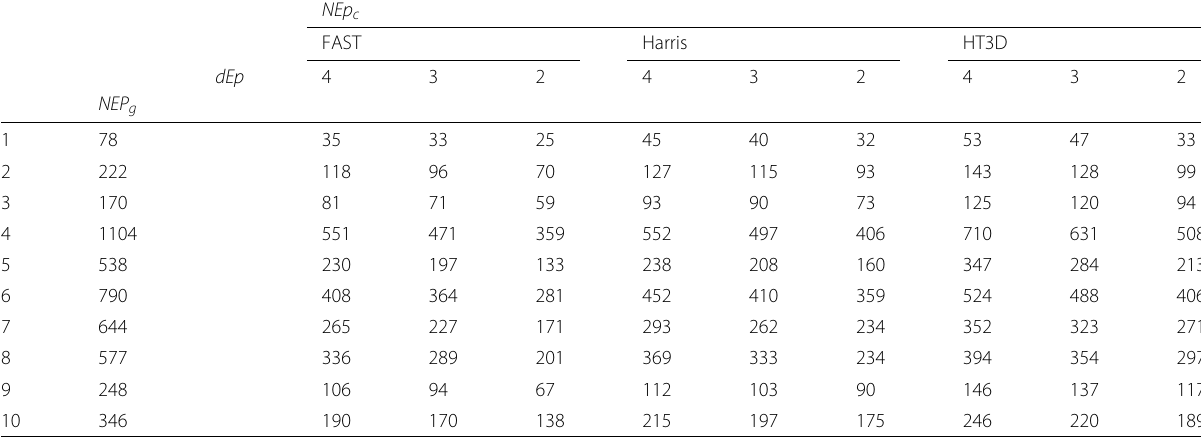
Table 2 Comparison of detected corners/endpoints with the ground truth for the ten test images NEp